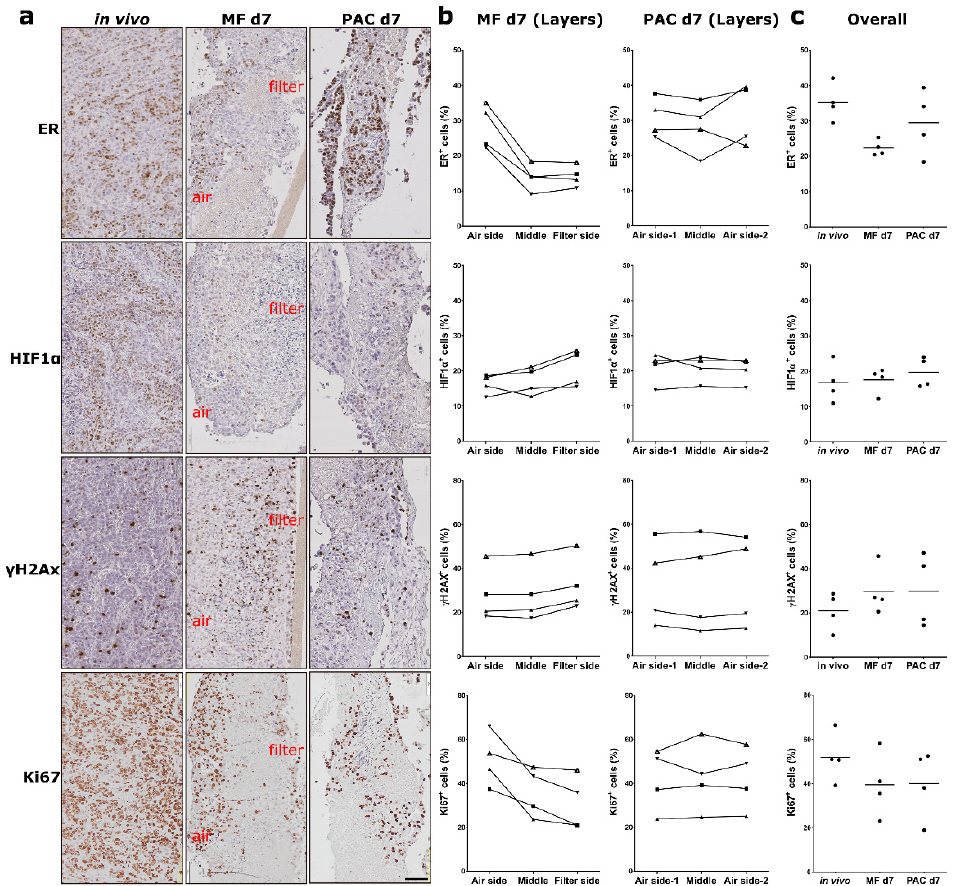
Figure 3. Expression of estrogen receptor (ER), hypoxia-inducible factor 1 α (HIF1 α ), phospho-histone H2A.X ( γ H2AX), and Ki67 of MCF-7 cell-line-derived xenograft (CDX) tumor slices in the Millipore filter (MF) culture system compared to the perfusion air culture (PAC) system after 7 days of culture. ( a ) Immunohistochemical (IHC) staining of biomarkers in MCF-7 CDX tumor slices after 7 days of cultivation either statically on a Millipore filter (MF) or in the perfusion air culture (PAC) system and compared to the original in vivo tumor. Air indicates the air side; filter indicates the filter side of the MF culture system. The scale bar represents 100 µm. ( b ) Quantification data of the percentage of cells expressing ER, HIF1 α , ɣ H2AX, and Ki67 in different longitudinal layers of the tumor slices after MF or PAC culture from four mice. In the figure, each shape of the symbol represents one mouse experiment. ( c ) Quantification data of the overall percentage of cells in whole tumor slices expressing ER, HIF1 α , γ H2AX, and Ki67 on MF, PAC systems and in vivo tumors from four mice.